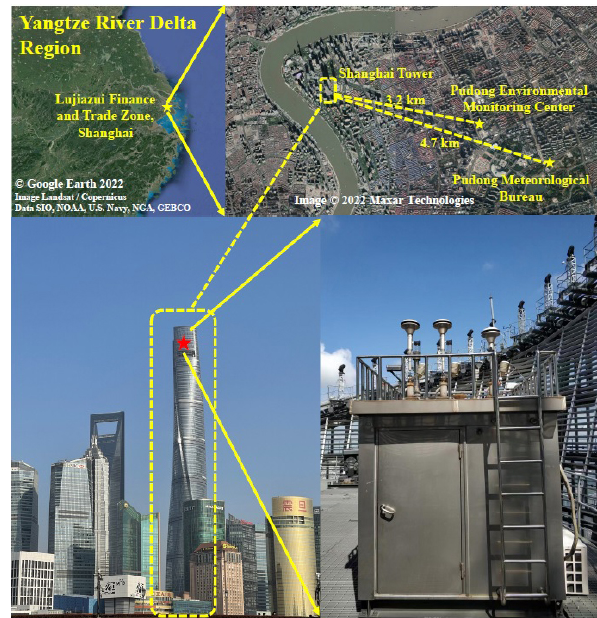
Figure 1. The deployment of the SHT site. The upper-left image gives a view of the Yangtze River Delta region (screenshot from Google Earth 2022 map data: data SIO, NOAA, US Navy, NGA, GEBCO. Image Landsat/Copernicus). The upper-right image shows the map of sample sites (image © 2022 Maxar Technologies). The red star in the lower-left photo denotes the platform at the top of